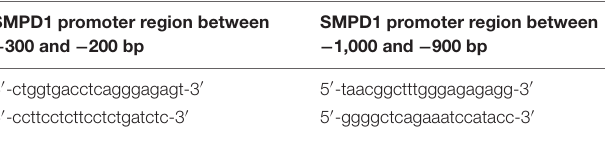
TABLE 2 | Oligonucleotide sequence for primers used in ChIP-qPCR analysis for TFEB binding to SMPD1 promoter. SMPD1 promoter region between − 300 and − 200